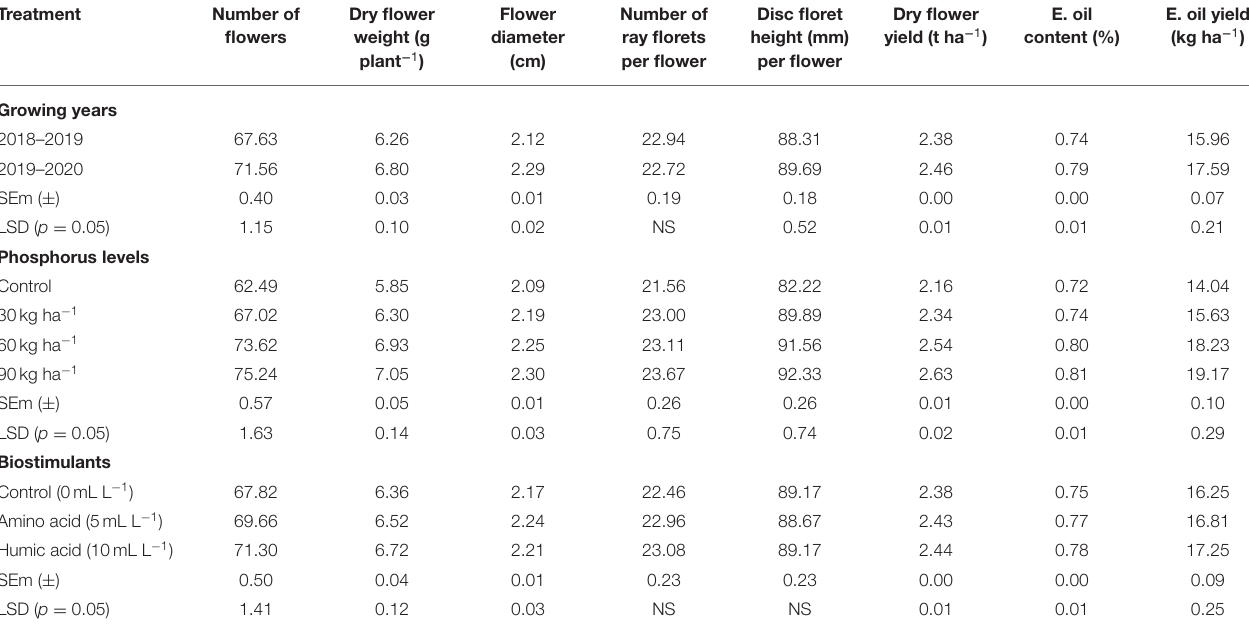
TABLE 3 | Growing years, phosphorus and biostimulant application influences yield attributes and yield in M. chamomilla at crop harvest.